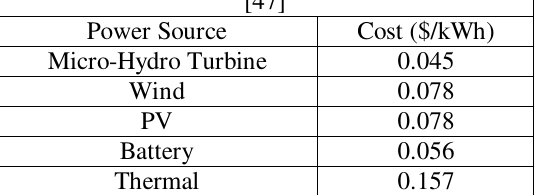
Table 2: Per unit cost of each type of generation